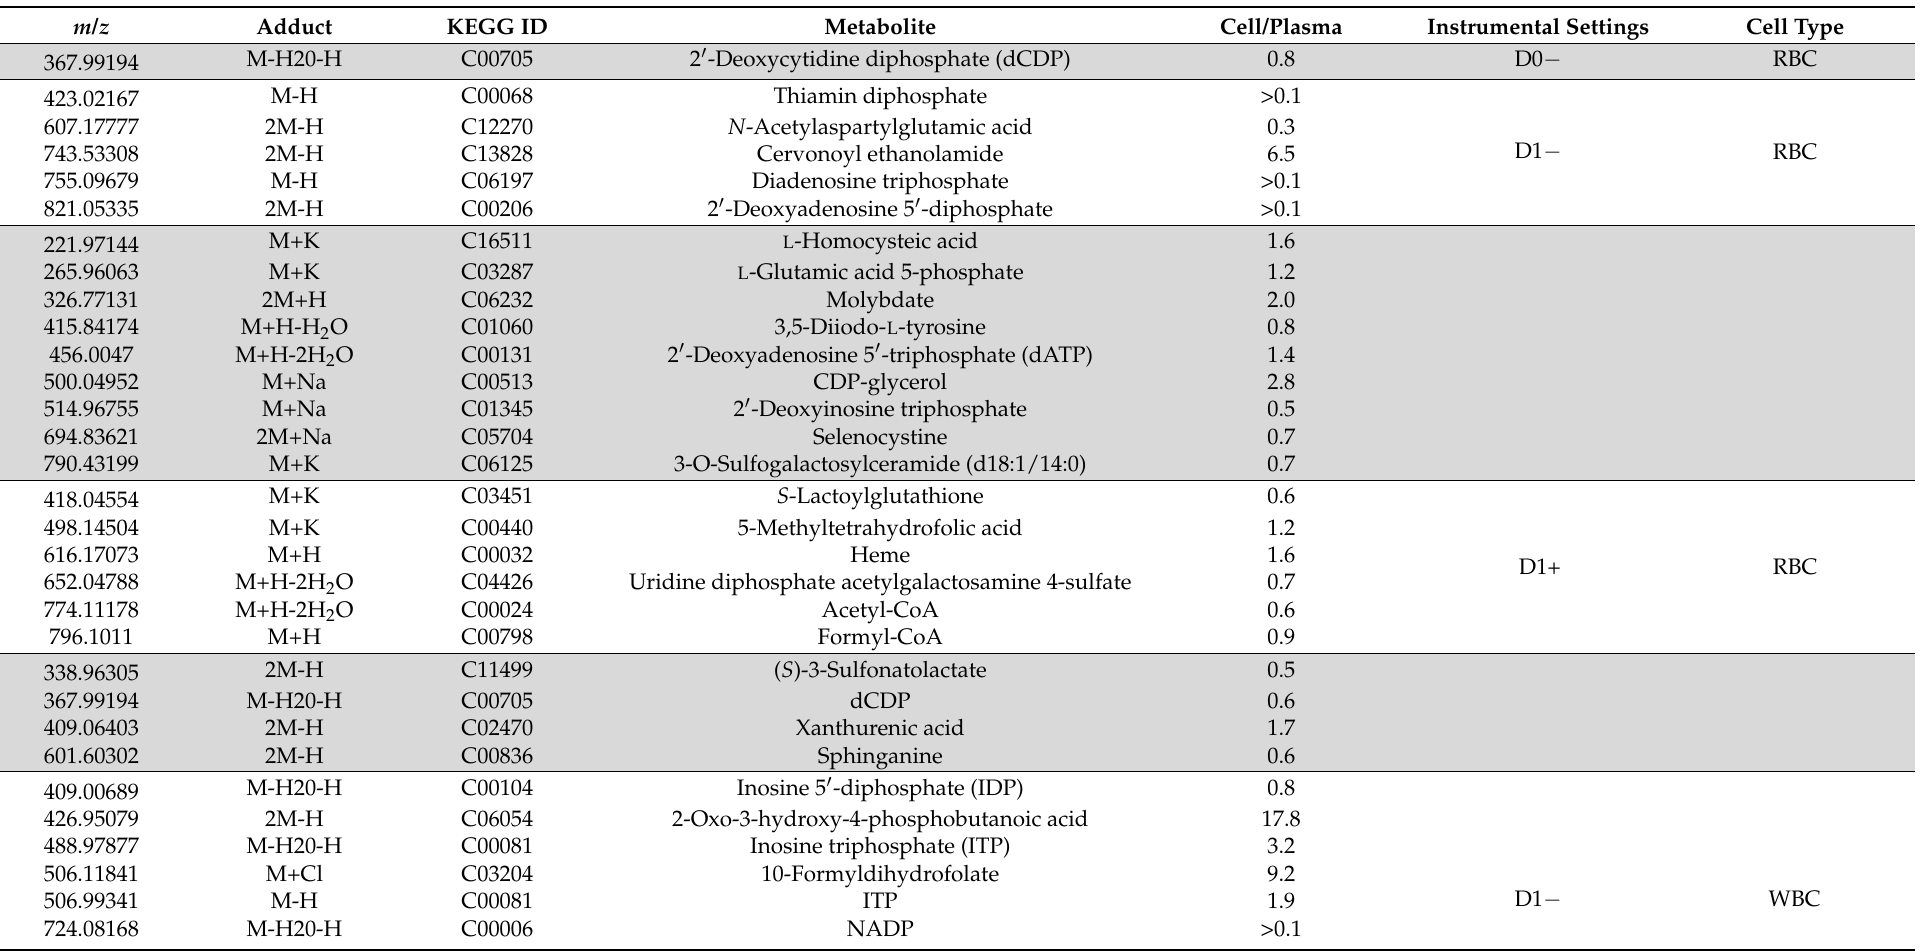
Table 2. Metabolites differentially expressed in RBC and WBC relative to plasma: metabolites were assigned to appropriate m / z signals by Human Metabolome Database (HMDB) and Kyoto Encyclopedia of Genes and Genomes (KEGG) database searches using ± 0.025 Da tolerance. Multiple database search hits like isobars were excluded: only the single hits that belong to endogenous or exogenous but essential compounds are